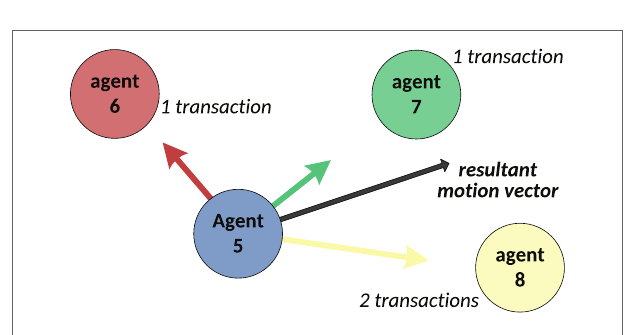
FigUre 6 | example of a motion vector as the resultant one of vectors toward other agents, where transaction history is taken into account . Agent 5 had one transaction with agent 6 and 7 and two with agent 8 (longer vector toward agent 8).